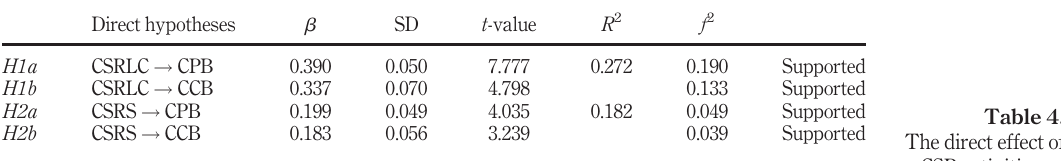
Figure 2. Direct effect of local